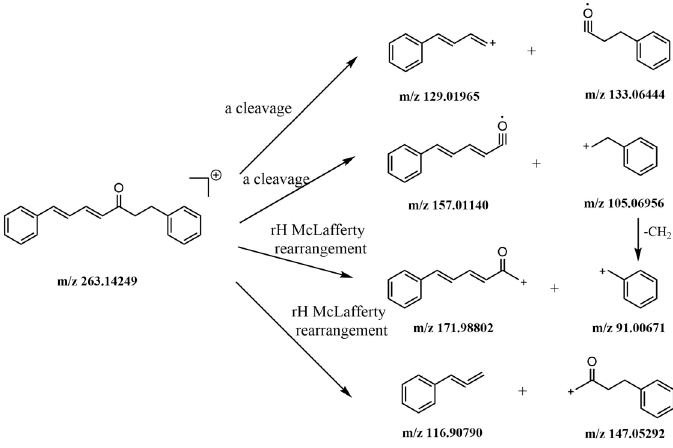
Figure 8. The mass spectrometric fragmentation processes of peak 73 alnustone.